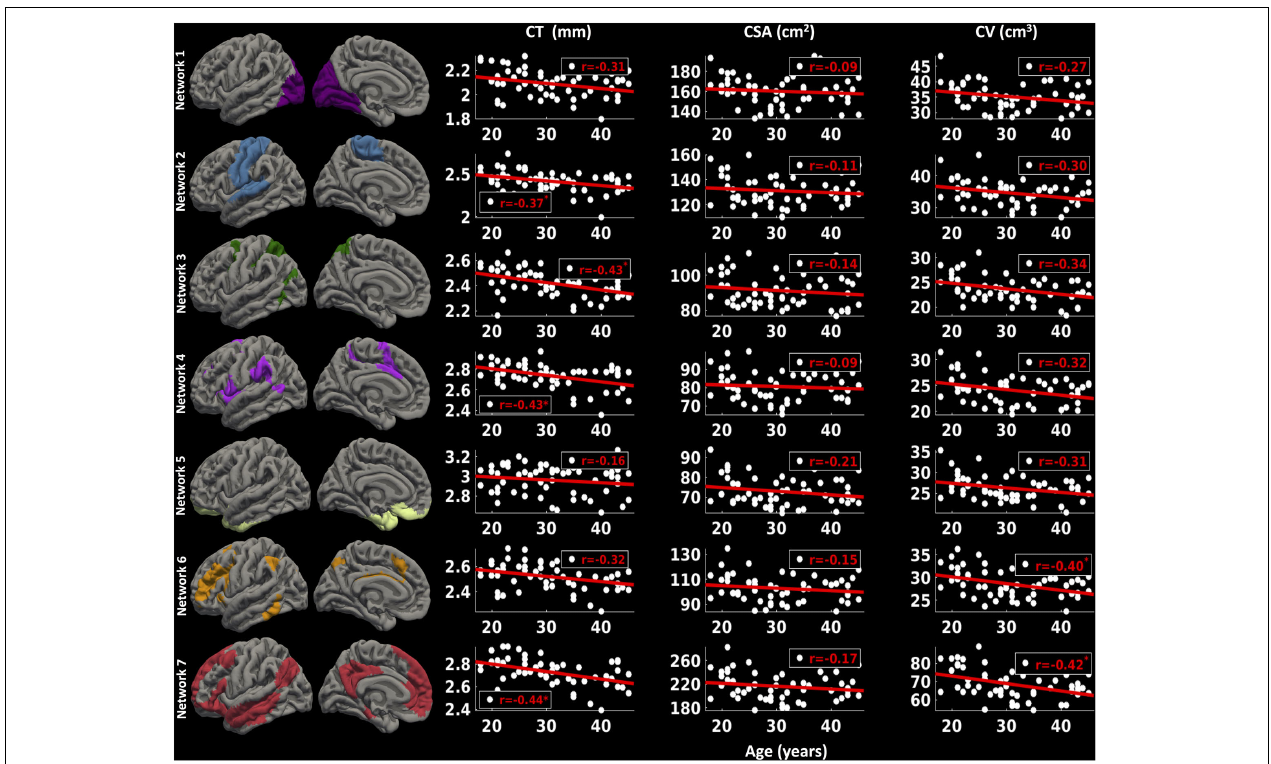
FIGURE 6 | Network-wise age-related changes in cortical measures for left hemisphere. Linear plots showing significant or trend toward significant reduction in cortical thickness (CT in mm) ( ∗ p < 0.05, corrected for multiple comparisons), non-significant reduction in cortical surface area (CSA in cm 2 ) and significant or trend toward significant reduction in cortical volume (CV in cm 3 ) ( ∗ p < 0.05, corrected for multiple comparisons) for seven functional networks on left